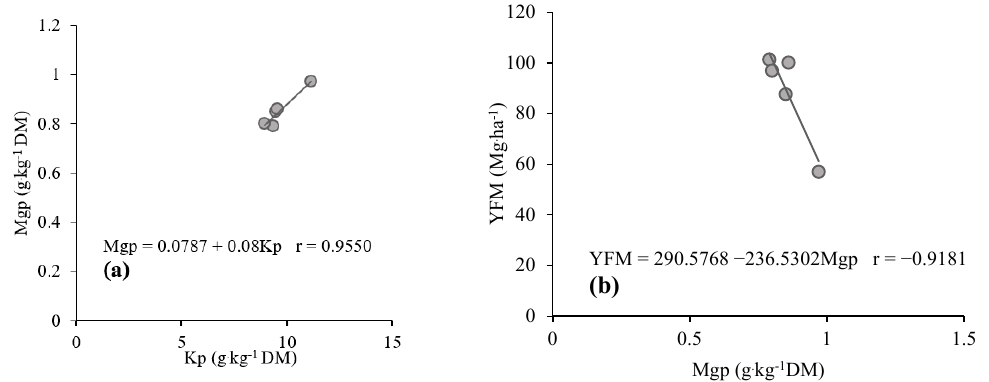
Figure 3. ( a ) The correlations between magnesium (Mgp) and potassium (Kp) content in maize dry matter (Pp), ( b ) magnesium (Mgp) and fresh matter yield (YFM). The highest phosphorus content was in 2014 (1.06 g · kg − 1 DM), with significantly lower amounts in 2015 and 2016 (0.75 g · kg − 1